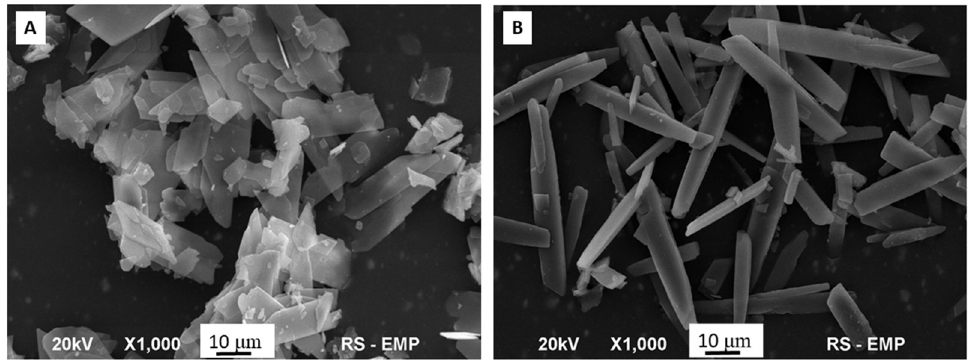
Figure 1. SEM images of Bru ( A ) and Se-Bru ( B ).